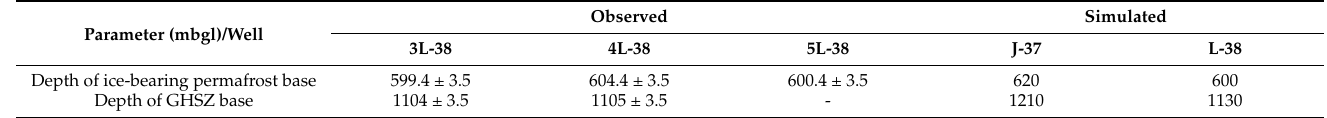
Table 5. Comparison of DTS-logged data [81] with the simulated key parameters of the permafrost and